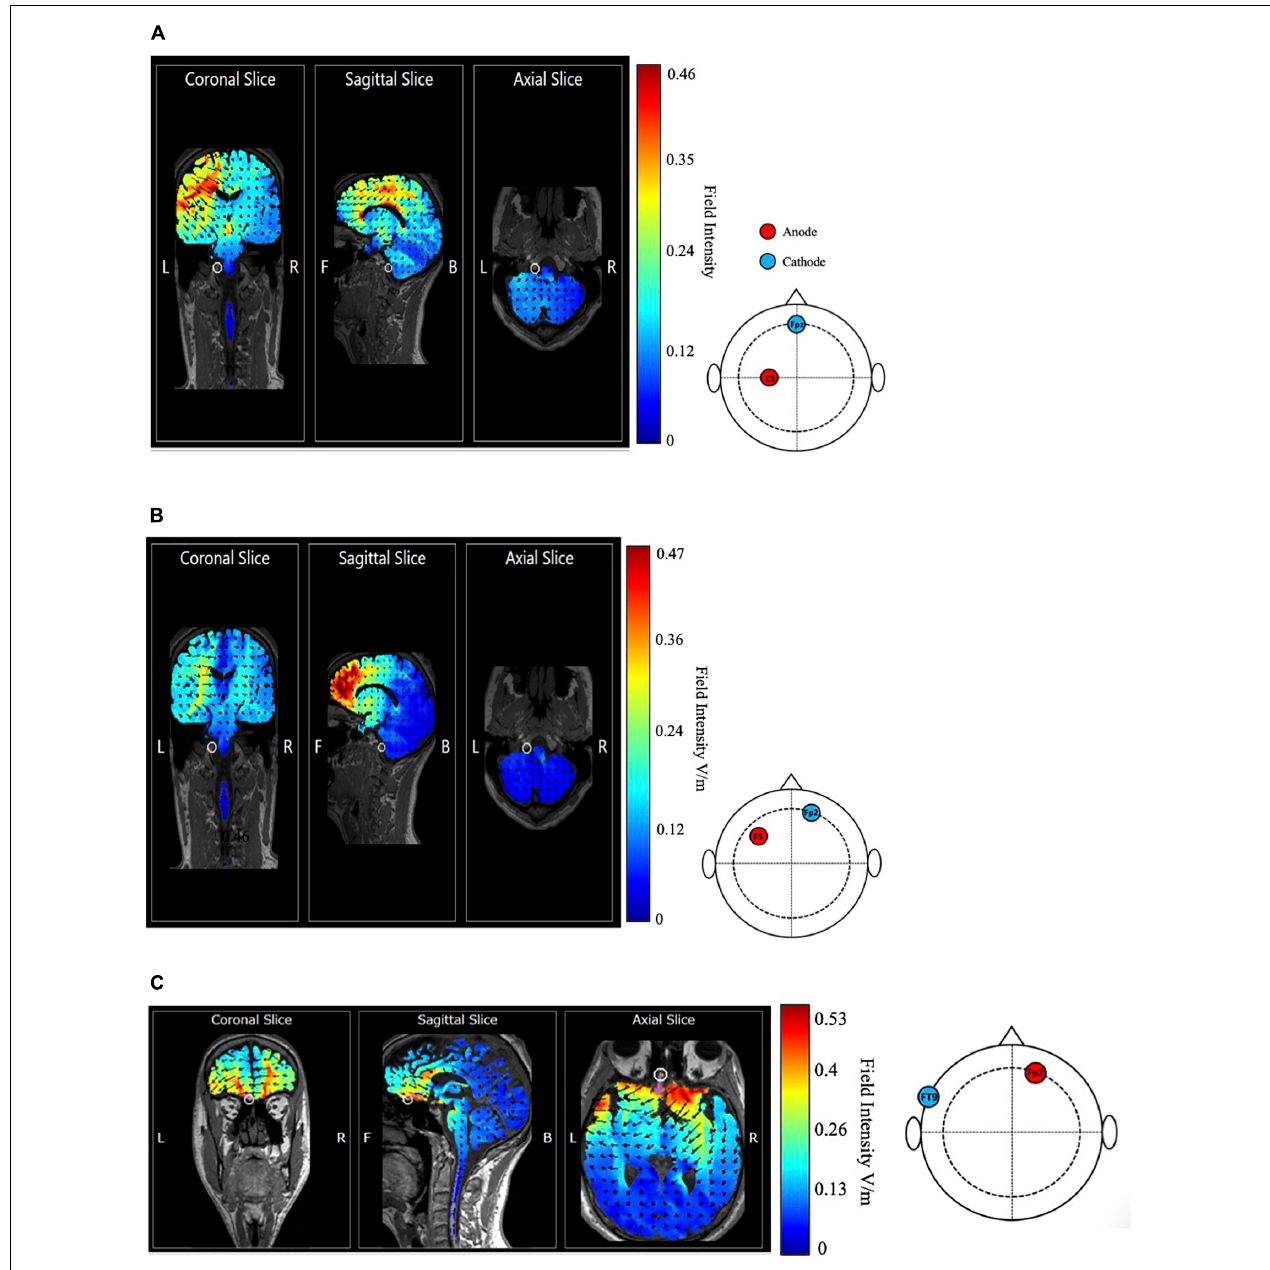
FIGURE 4 | Simulated distribution of the tDCS induced current in the brain with the montage of (A) Nakamura and Kawabata (2015), (B) Cattaneo et al. (2014) and (C) which was designed to maximally stimulate the OFC in the coronal, sagittal, and axial view. Red area indicates a high current field intensity, and blue area indicates a low current field intensity. Arrows show predicted current